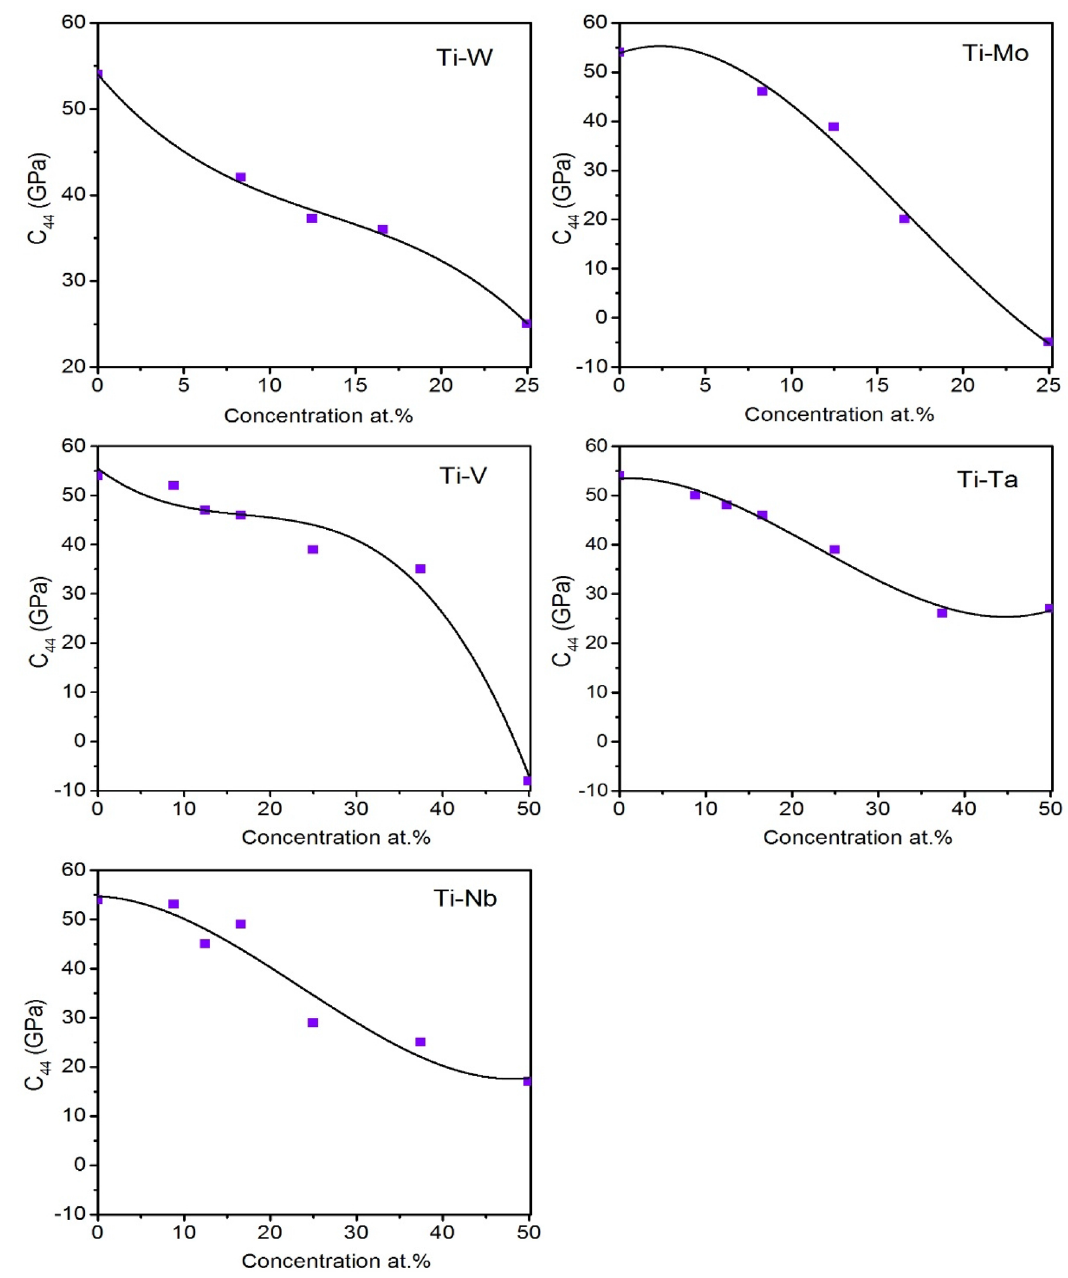
Figure 5. Calculated C 44 elastic constants of the ω-phase Ti-X binary systems (X = W, Mo, V, Ta, and